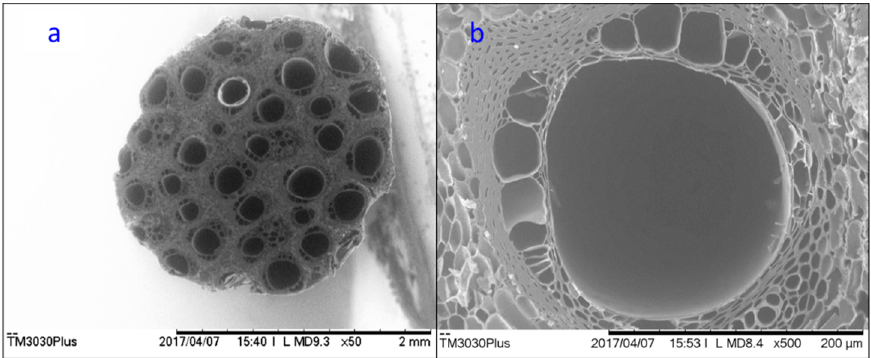
Figure 3. SEM images of the tubular carbon membranes from the rattan precursor: ( a ) the whole tubular (d o = 2.2 × 10 − 3 m); ( b ) single channel (d i = 2×10 − 4 m).